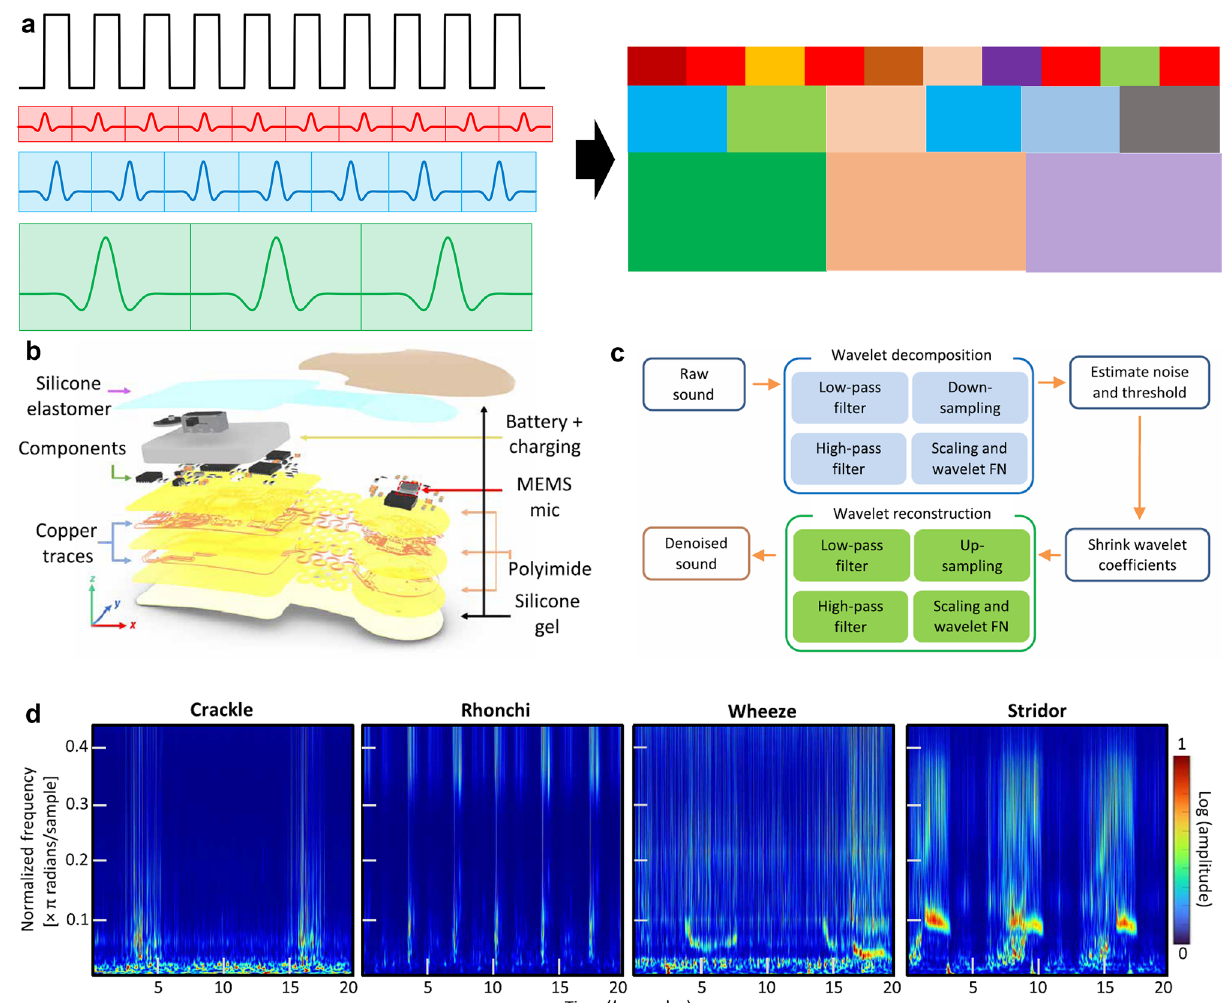
Fig. 17 Signals detected by the soft system and processed by WT. a Schematic diagram of WT. b Exploded view of the SWS with multiple lay- ers of deposited materials. c Schematic illustration of the flowchart of the wavelet denoising algorithm to realize decomposition and recomposi- tion of collected sounds. d Scalogram of crackle, rhonchi, wheeze, and stridor data in sample series versus normalized frequency with density after the wavelet denoise for each sample. Reproduced with permission [29]. Copyright (2022), American Association for the Advancement of